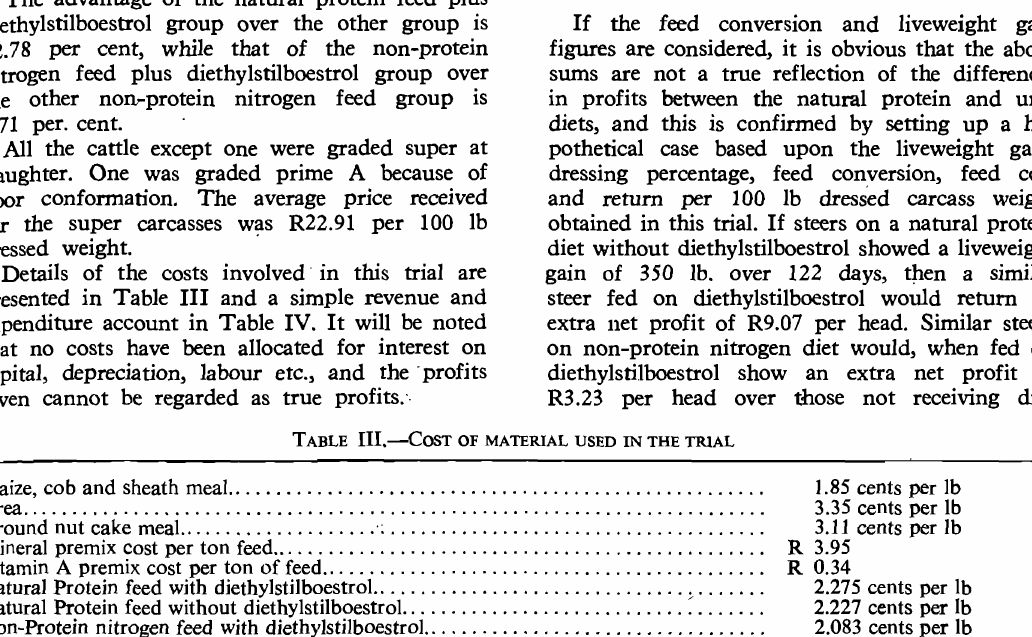
TABLE I1I.-COST OF MATERIAL USED IN THE TRIAL